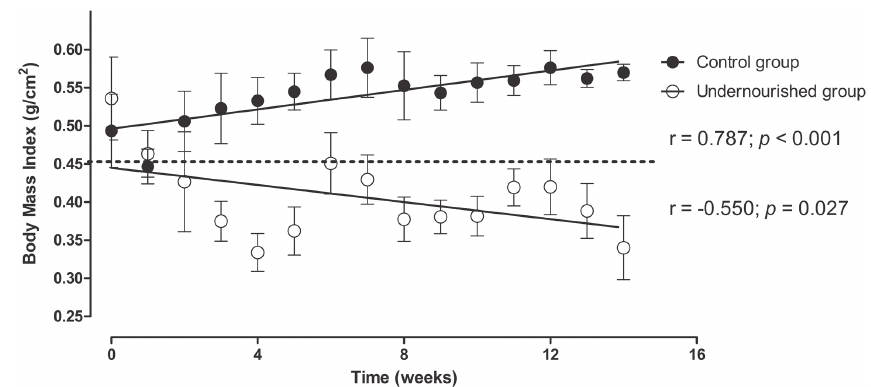
Figure 1 - Evolution of Body Mass Index (BMI) of control and undernourished groups. r: correlation coefficient and p : significance level; according to the Pearson’s test. The dashed line indicates the cutoff for classification of undernourishment in the rat BMI, according to Novelli et al.